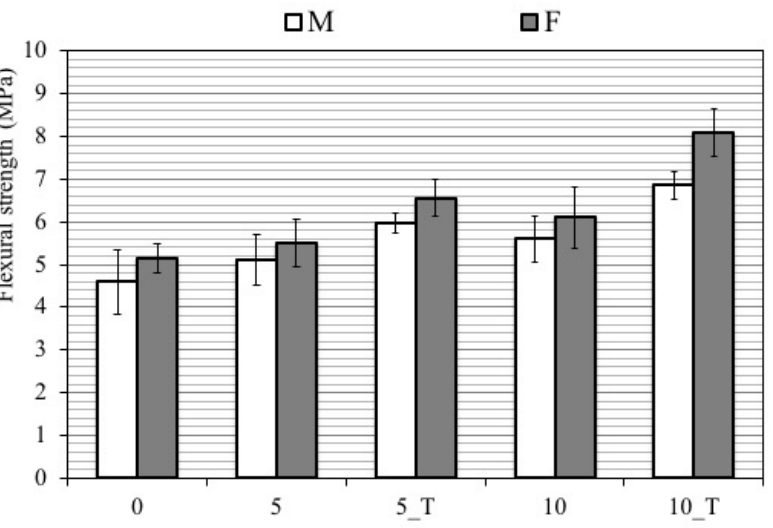
Figure 5. Flexural strength of the investigated materials. Figures 6 and 7 report the plot of the load/mid span deflection results for the fly ash and metakaolin samples respectively.